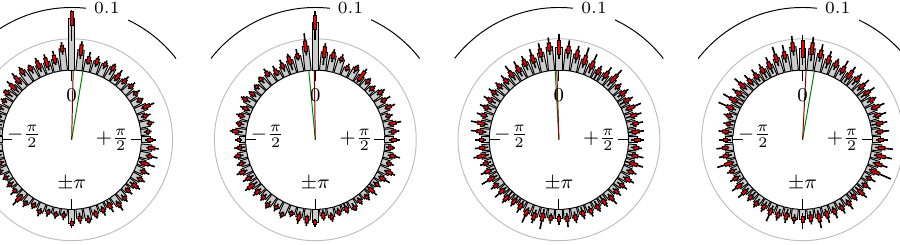
Figure 19. Oil (WTI) versus